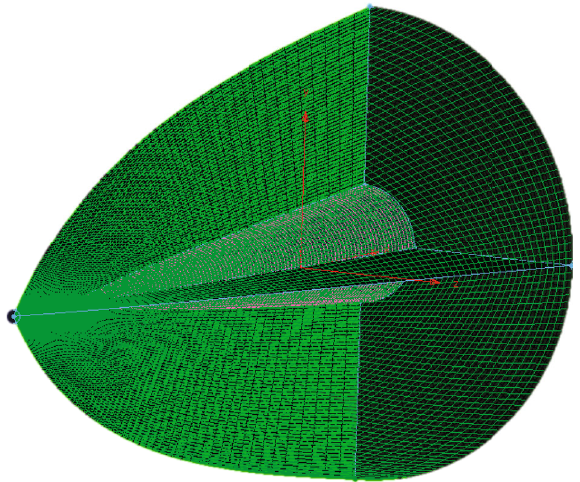
Figure 7: The two-block and structured mesh gird